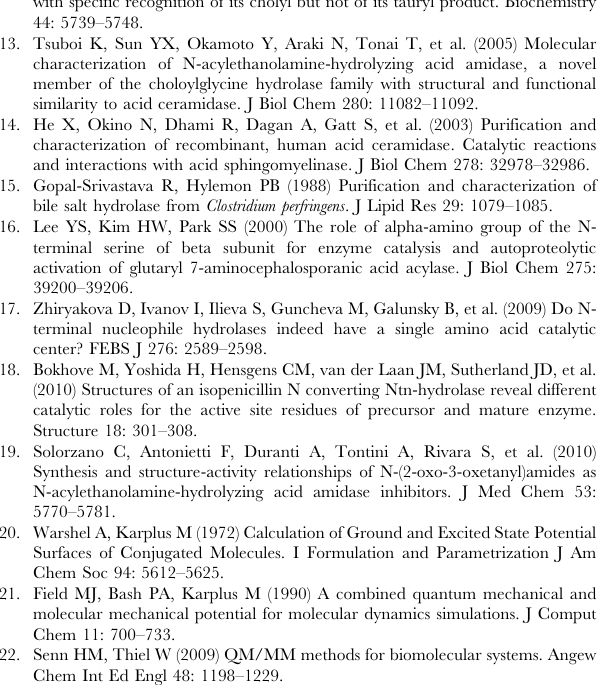
Figure S3 Work profile of the first step of TAU hydrolysis by CBAH over S . Work profile of the first step of TAU hydrolysis by CBAH over S by steered-MD, compared with free energy profile obtained with umbrella sampling (and also reported in Figure 6A of the main text). Figure S4 Reactant complex formed by Cys-OMe and TAU substrate. Reactant complex formed by Cys-OMe and TAU substrate as a model system to simulate amide hydrolysis in solution. Water molecules within 6 A˚ from the reactive center are displayed. Figure S5 First step of TAU hydrolysis by Cys-OMe in solution. A , B , and C are key steps for the cleavage of TAU amide bond. Figure S6 Comparison between TAU hydrolysis in CBAH and in solution. Activation barriers for the first step of TAU hydrolysis catalyzed by CBAH (line) and in aqueous solution (dashed line), estimated from work profiles obtained from steered- MD/PCVs simulations. In the lower panel, relevant distances are plotted as a function of S (progress along the path). Figure S7 Superposition of the transition state (TS) structures for the reaction in CBAH solution and in CBAH. TS structures were identified along steered-MD/PCVs simulations. The TS geometry for the reaction in aqueous solution is reported with white carbon, while the TS geometry for the enzyme catalyzed reaction is reported with black carbons.